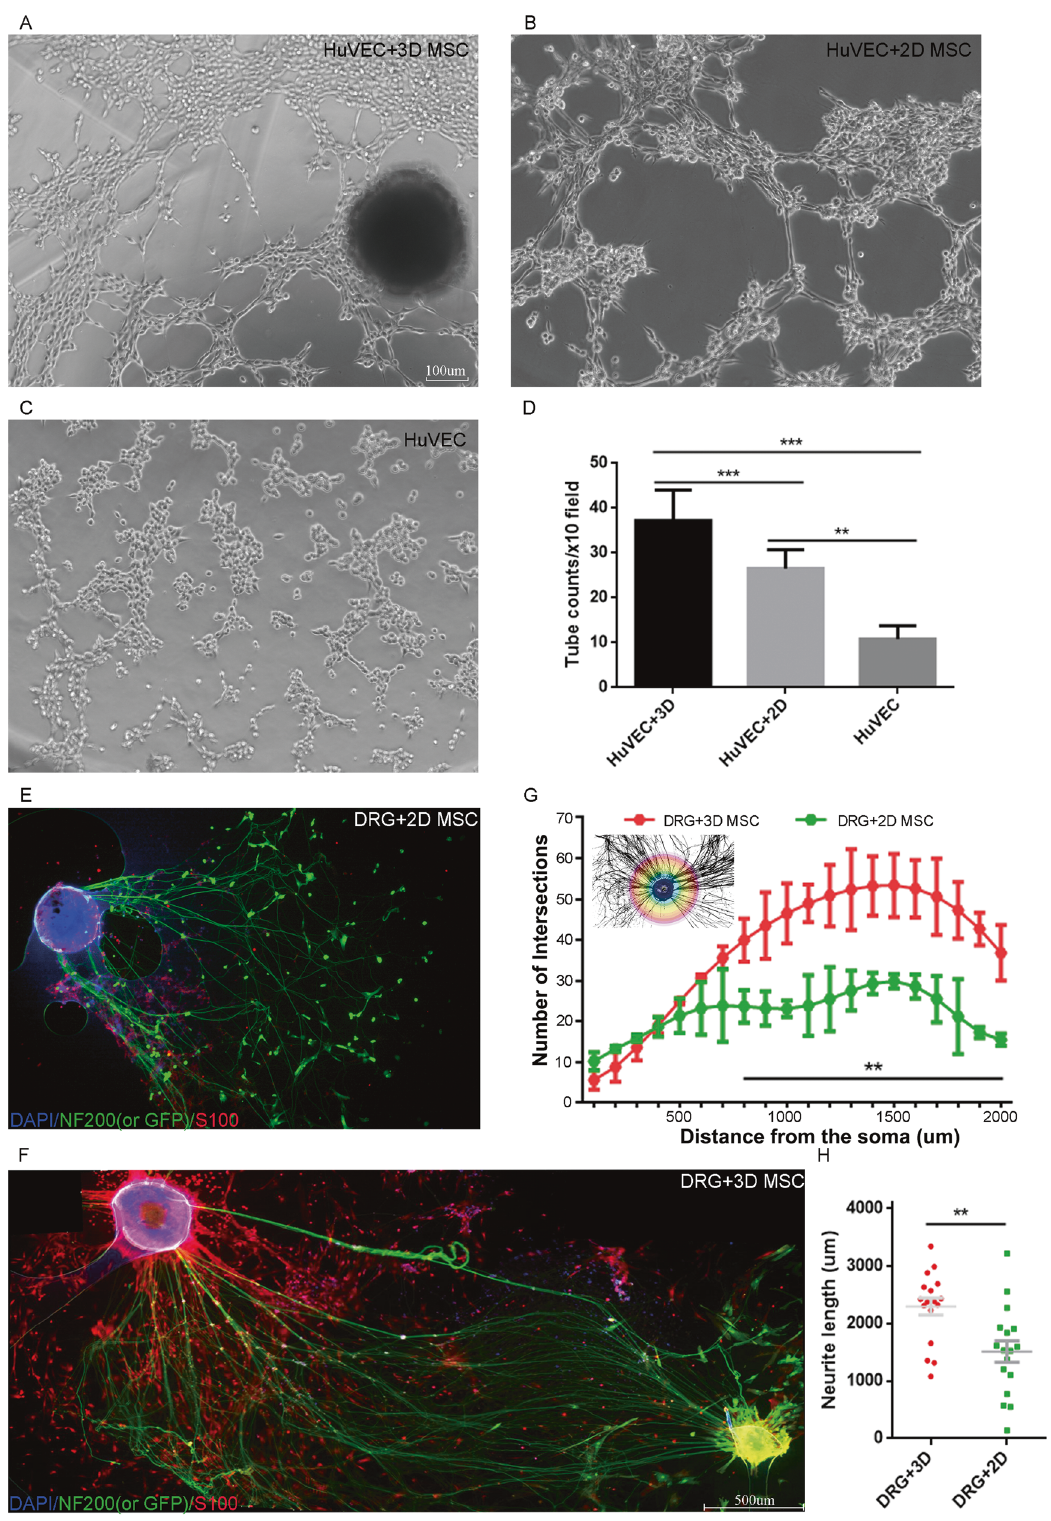
Fig. 3 The effects of 3D-HPMSCs on angiogenesis and neurite morphogenesis. A – C Representative images showing the tube formation of HUVECs co-cultured with 3D-, 2D-HPMSCs, or medium alone. D There were more new vessel tubes formed in the 3D-HPMSCs co-culture group. E , F The DRG neurite outgrowth co-cultured with 2D and 3D-HPMSCs. Scale bar, 500 µm (E, F). G More branch points were observed in the 3D-HPMSCs co-culture as the distance increased from the soma. H Longer neurites were observed in the 3D-HPMSCs co-culture group. The number of branch points and the total length of neurites were collected using Sholl analysis ( G ) and simple neurite trace analysis ( H ). ∗∗ , and ∗∗∗ indicate P < 0.01, and P < 0.001, respectively.